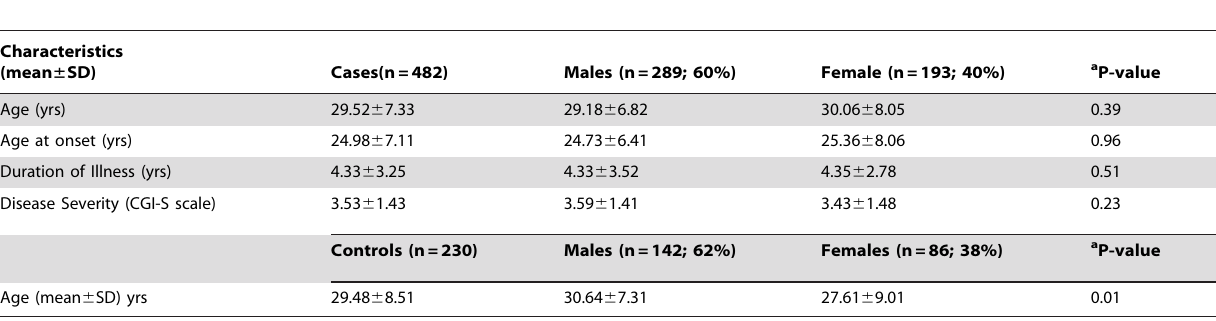
Table 1. Demographic and clinical characteristics of schizophrenia cases (n =482) and healthy controls (n=230) enrolled in the